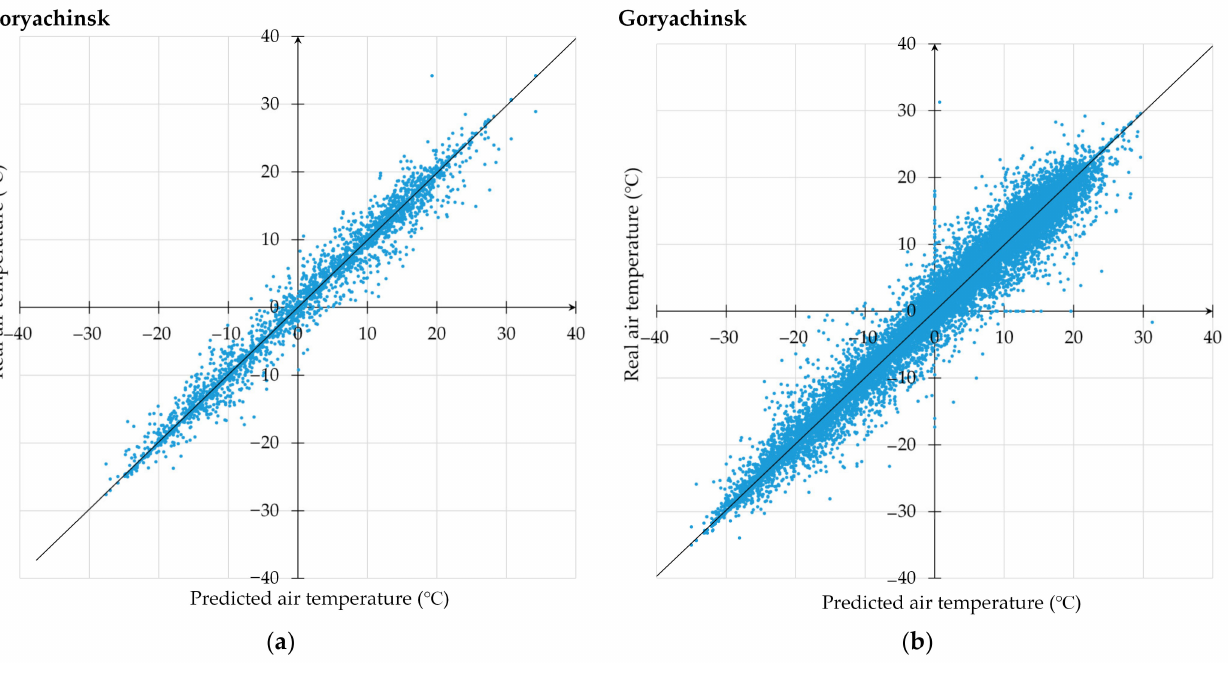
Figure 9. Prediction error scatter of (cid:101) x w